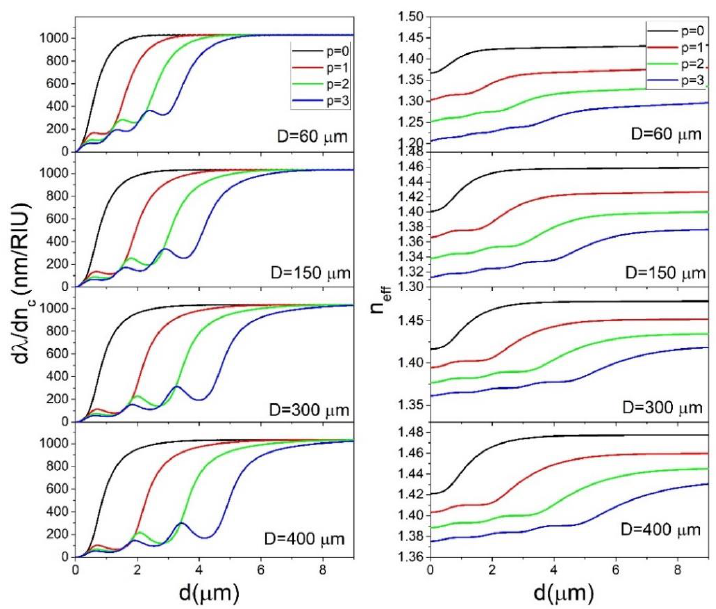
Figure 4. The dependence of ∂λ / ∂ n c ( left ) and n eff for l = m ( right ) on d for n c = 1.5 calculated for select values of p and D .